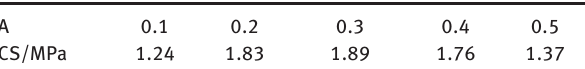
Table 3: The CS of coal-based electrode materials with different A (10°C/min, 800°C).